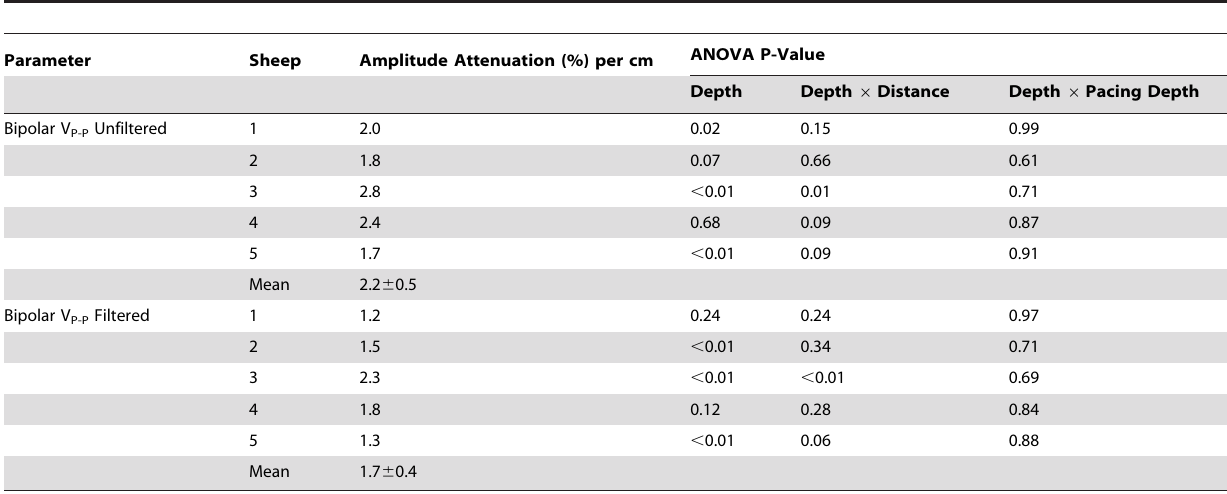
Table 2. Within subject analysis of the effect of propagation distance (covariate), transmural recording depth (treatment), and pacing depth (treatment) on unfiltered and 30 Hz high-pass filtered bipolar electrogram parameters measured.